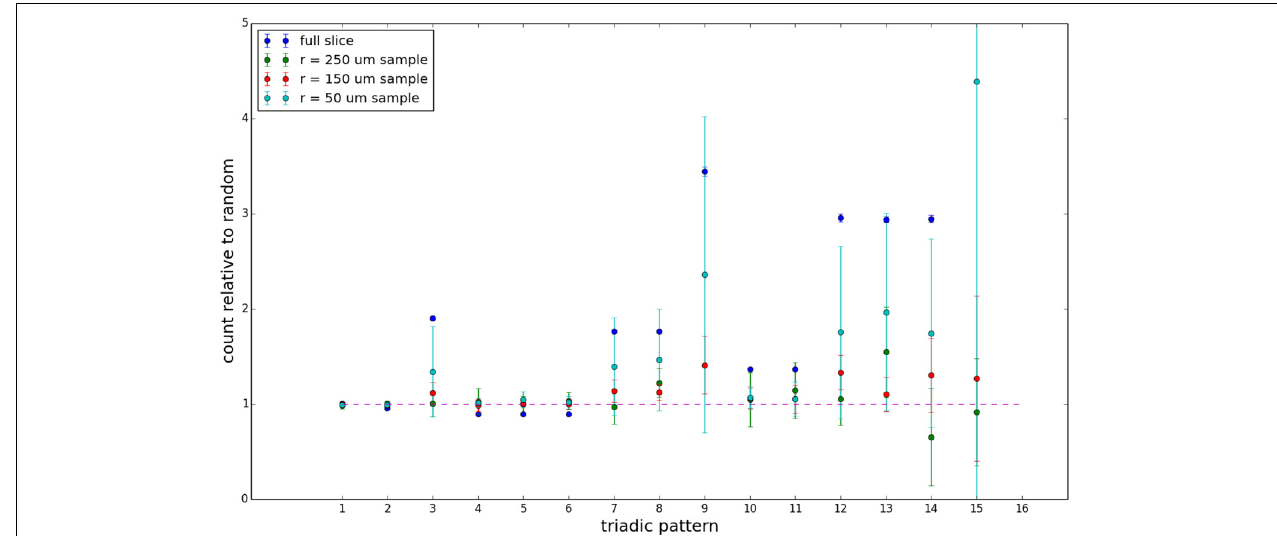
FIGURE 9 | Triadic motif counts for 300 µ m slice. Error bars indicate standard error of the mean. Average over five populations.